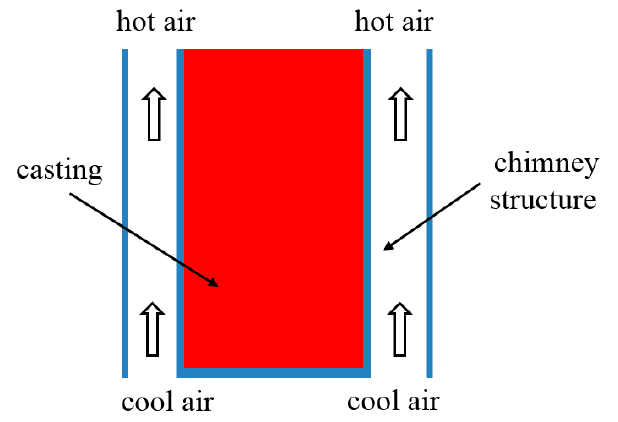
Figure 1. Schematic of the chimney structure.